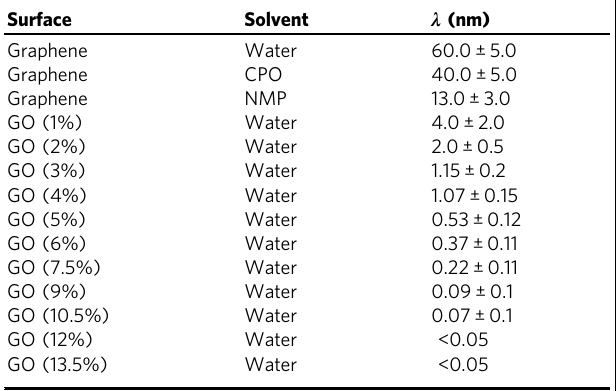
Table 1 Slip length λ as measured from MD.